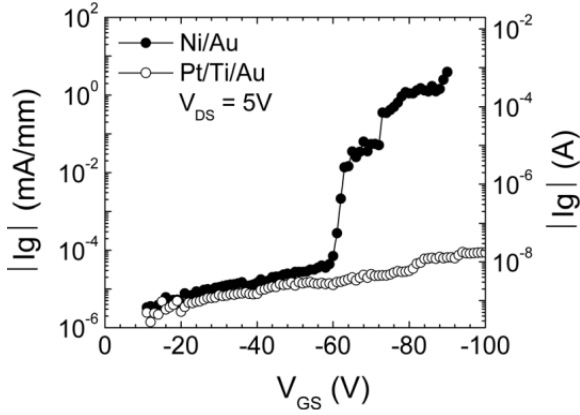
Figure 8. Off-state gate currents as a function of gate metal for AlGaN/GaN HEMTs fabricated with Ni/Au or Pt/Ti/Au gate